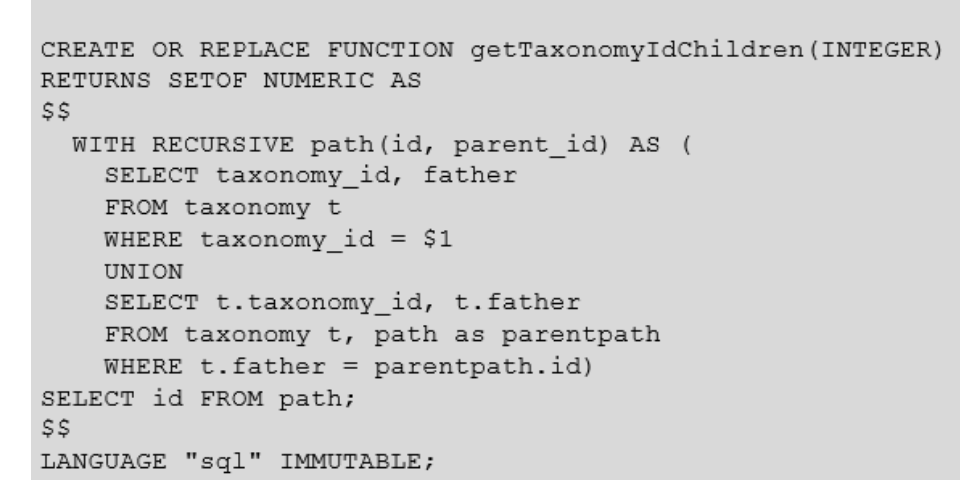
Figure 8. Function: GetTaxonomyIdChildren.